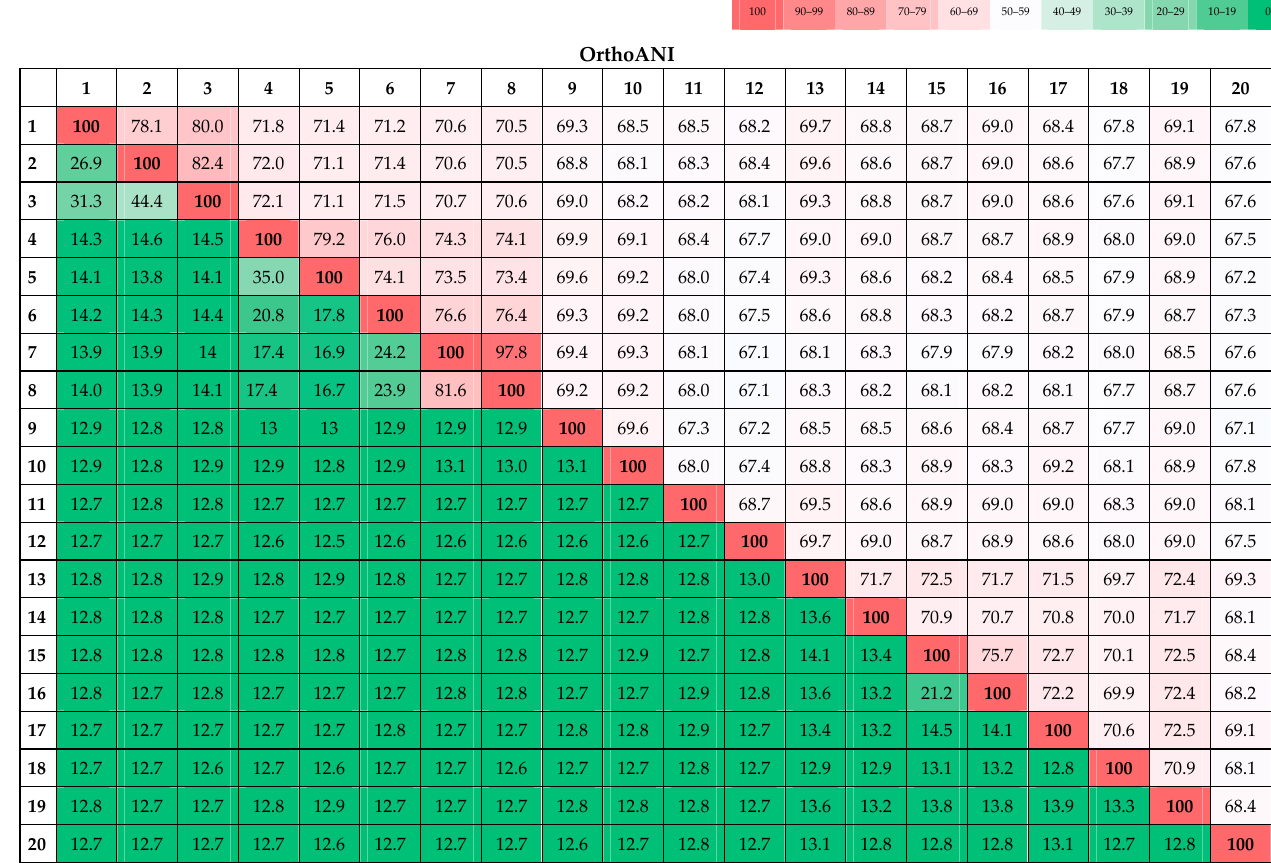
Table 2. Percentages of GGDC and OrthoANI between strain GBPx2 T and members of the family Cyclobacteriaceae.